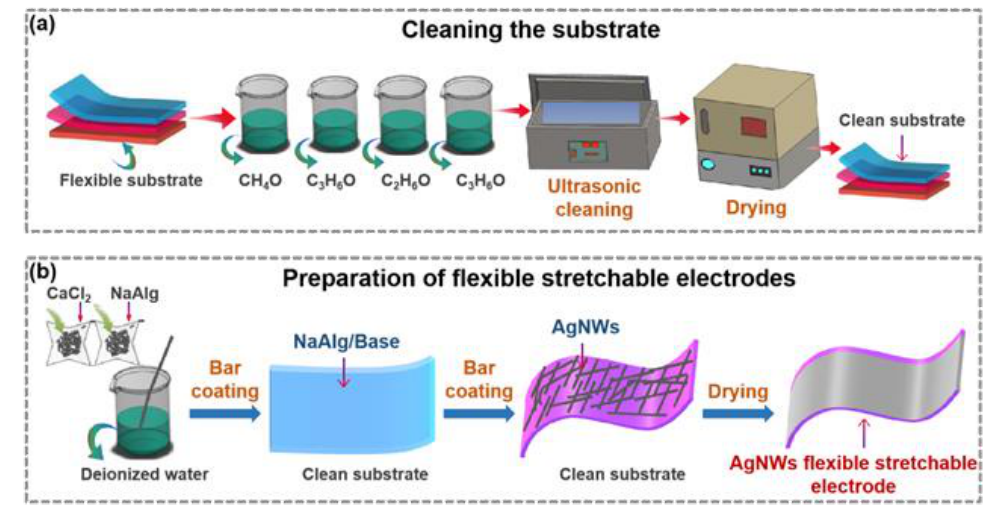
Figure 2. ( a ) Schematic illustration of cleaning the substrate; ( b ) Schematic illustration of the prepa- ration of flexible stretchable